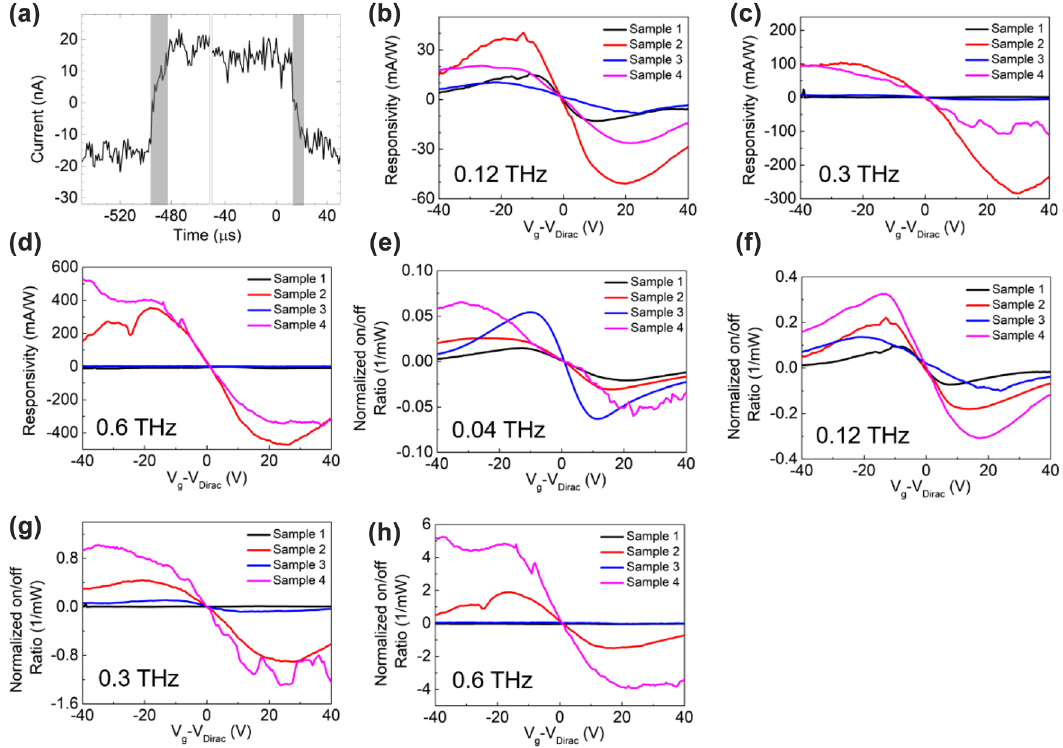
Figure 4: The oscillogram, the responsivity and normalized on/off ratio. (a) The current response as a function of time at 0.04 THz illumination, 0 V gate voltage and 0 V source–drain bias. (b–d) show the responsivity of all devices as a function of gate voltage at (b) 0.12 THz, (c) 0.3 THz and (d) 0.6 THz illumination. (e–h) show the normalized on/off ratio (normalized to the power density) of all devices as a function of gate voltage at (e) 0.04 THz, (f) 0.12 THz, (g) 0.3 THz and (h) 0.6 THz